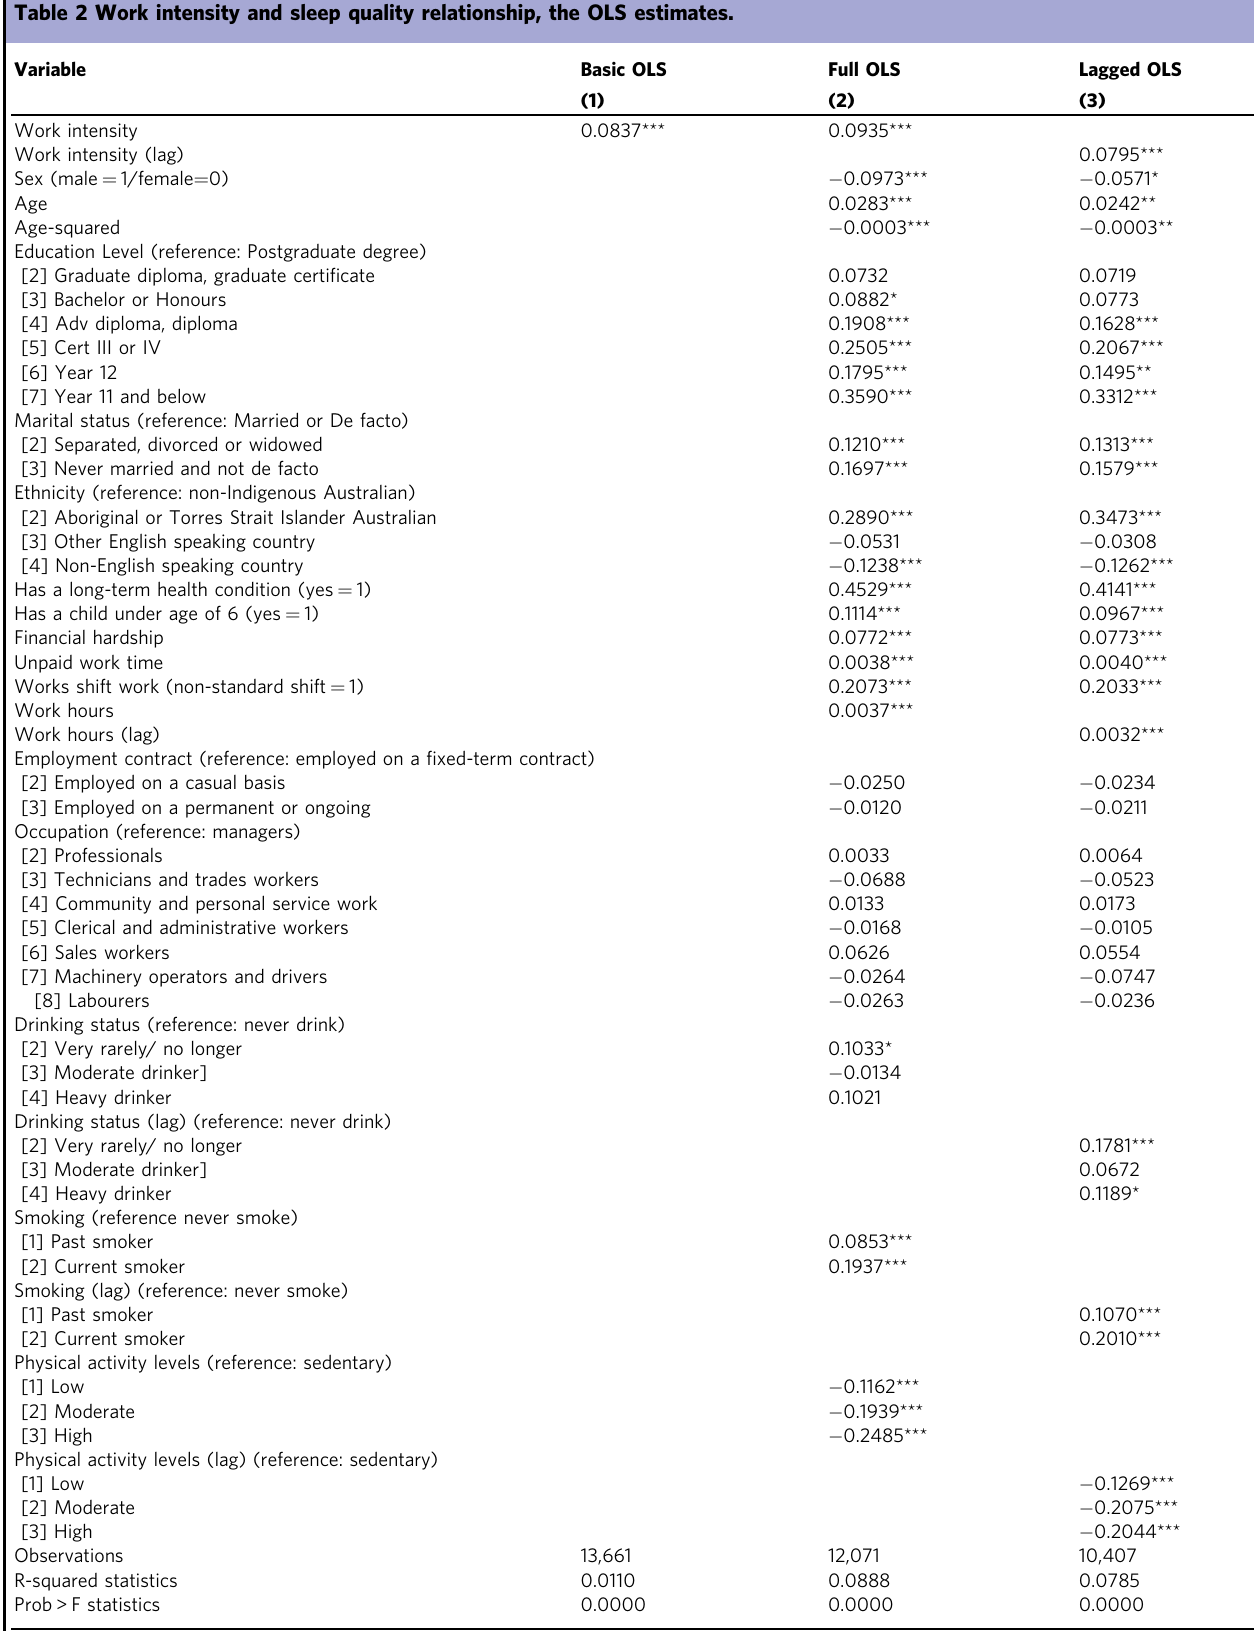
Table 2 Work intensity and sleep quality relationship, the OLS